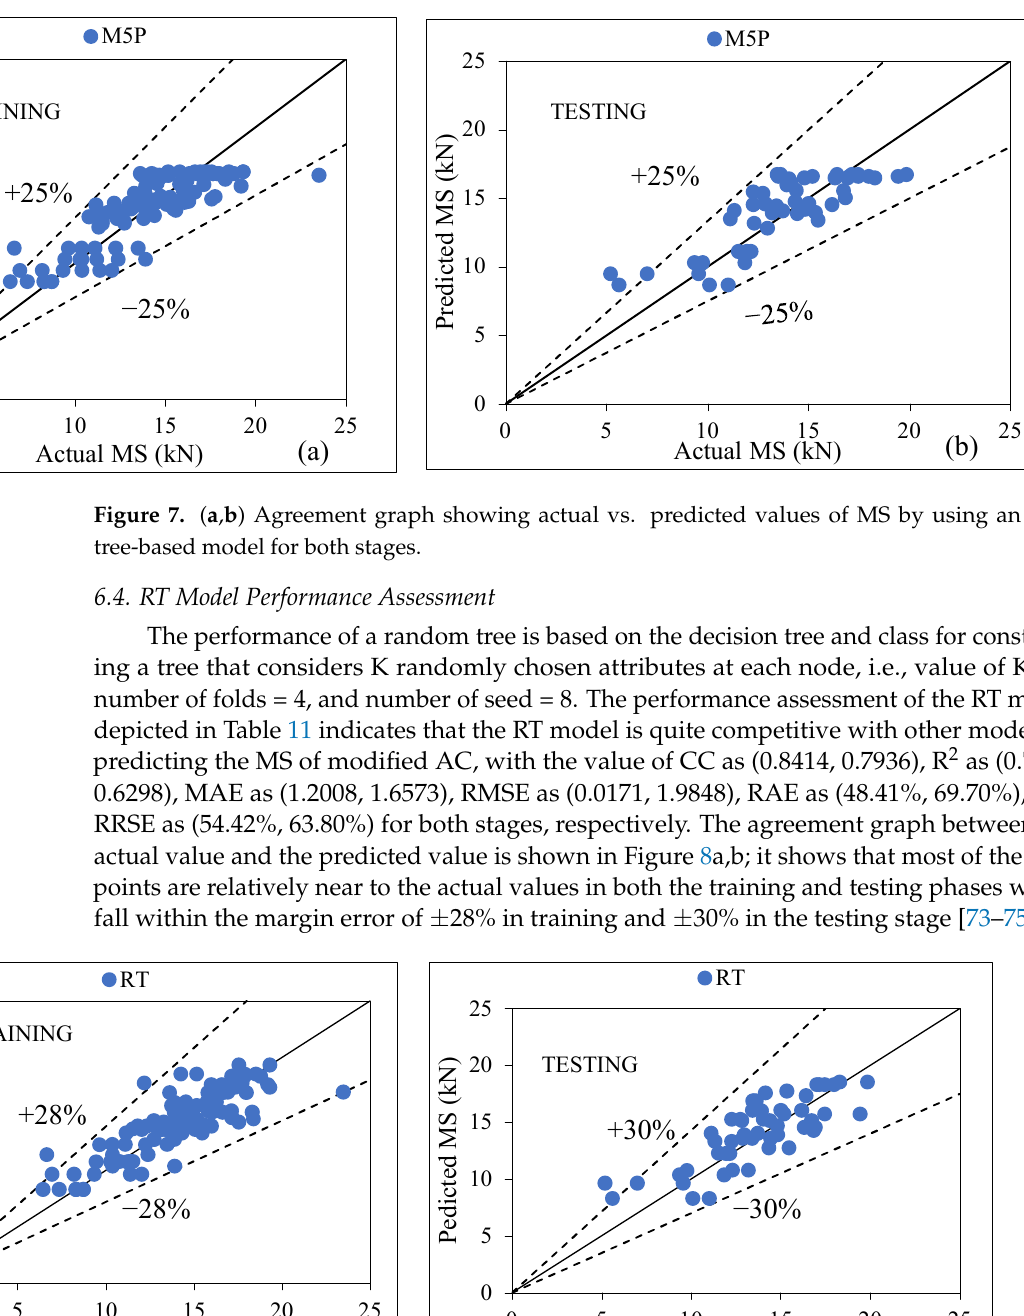
model for both stages.